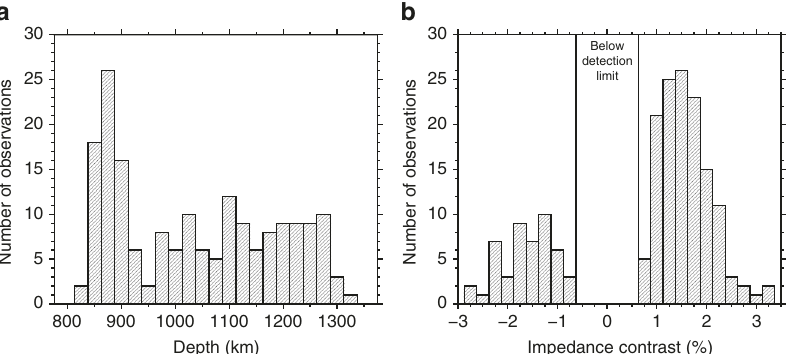
Fig. 4 Depths and impedance contrast of observed mid-mantle re fl ectors. a Histogram of discontinuity depths showing bins of all sizes. b Histogram of impedance contrasts estimated from shear-wave velocity contrasts. For corresponding histograms for all bin sizes, see Supplementary Figs. 6 and 7